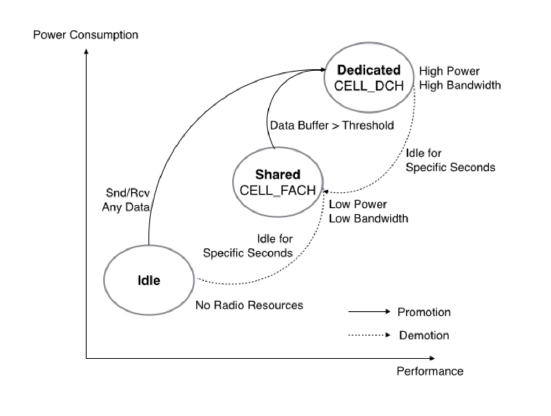
Figure 1: RRC State Machine for UMTS